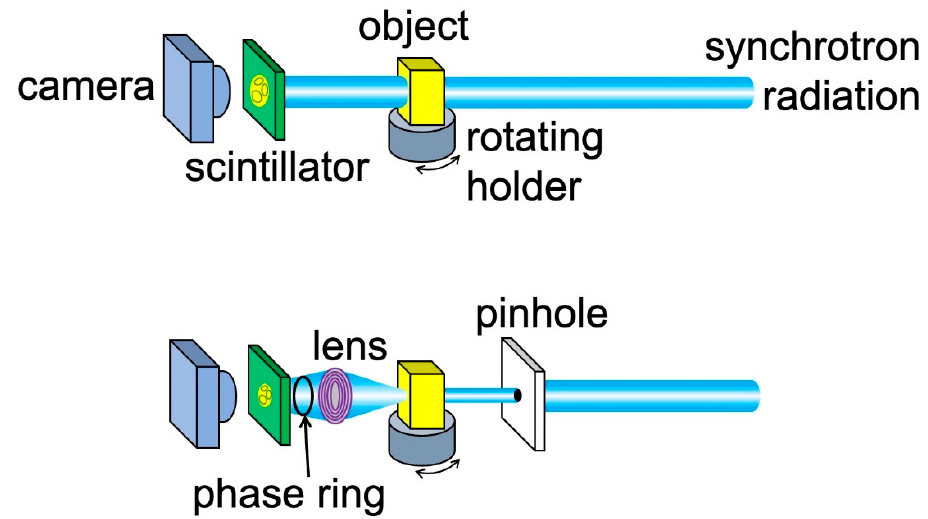
Figure 12. Two online experimental geometries to implement a radiography system based on edge enhancement. ( Top ): the simplest arrangement, which does not include any magnification. ( Bottom ): geometry for radiographic microscopy, based on an X-ray lens (see Section 2.5). This configuration also offers the option of a phase-adjusting device to enhance the contrast, as mentioned later in the text.